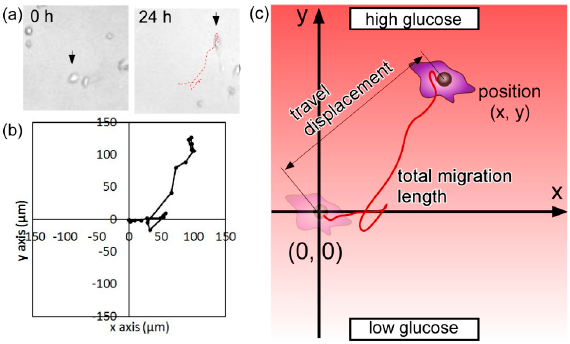
Figure 13. Parameters used to analyze the mobility of HeLa cells. ( a ) Images of HeLa cells at the beginning and 24 h after the experiment. Red dashed line indicates the trajectory of a cell; ( b ) Cell trajectory over a period of 24 h; ( c ) Parameters used to describe cell mobility.